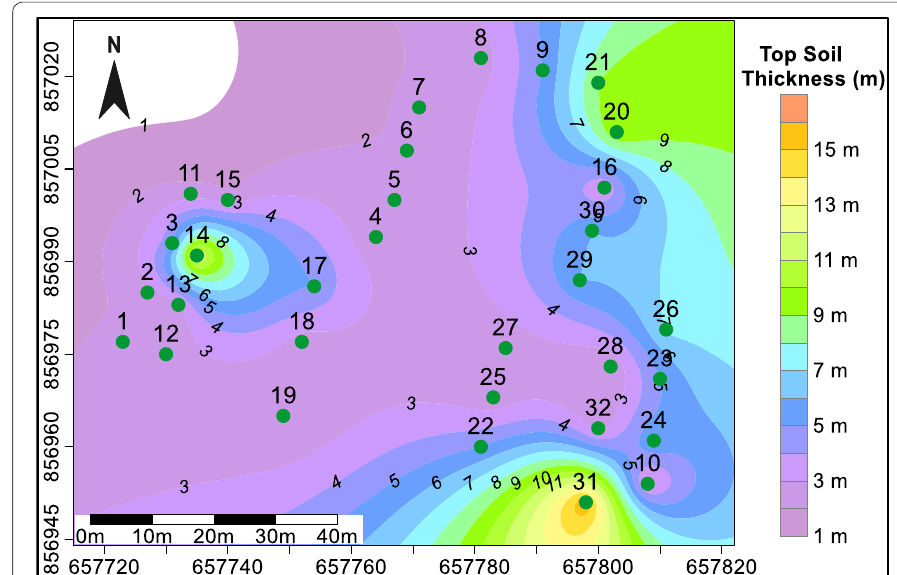
Fig. 10 Isopach map showing the topsoil thickness distribution